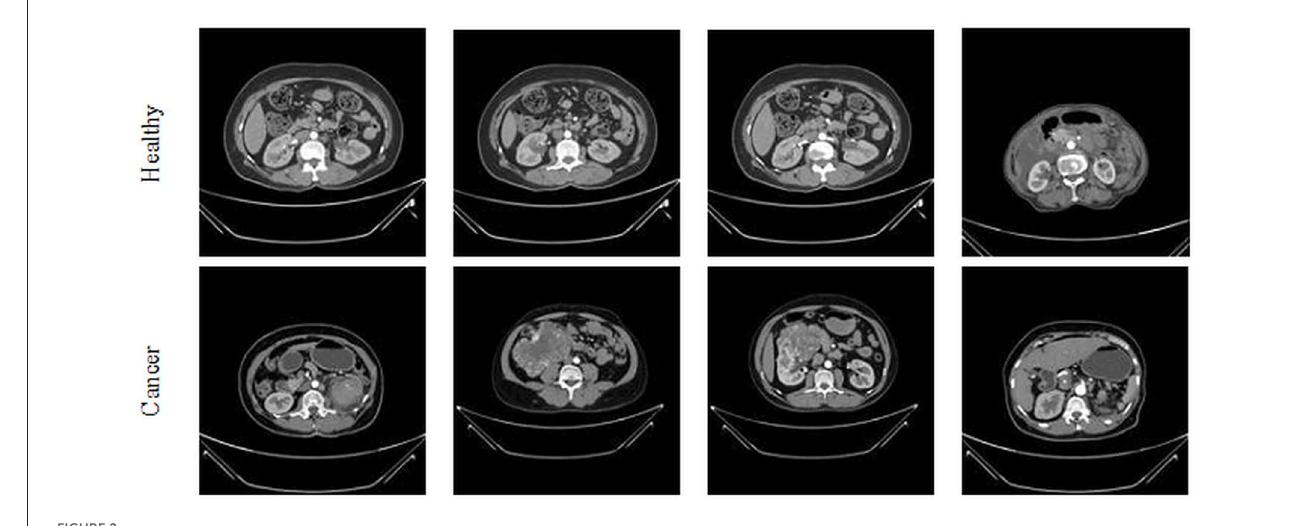
FIGURE2 Sample axial-plane test images of renal CT slices.